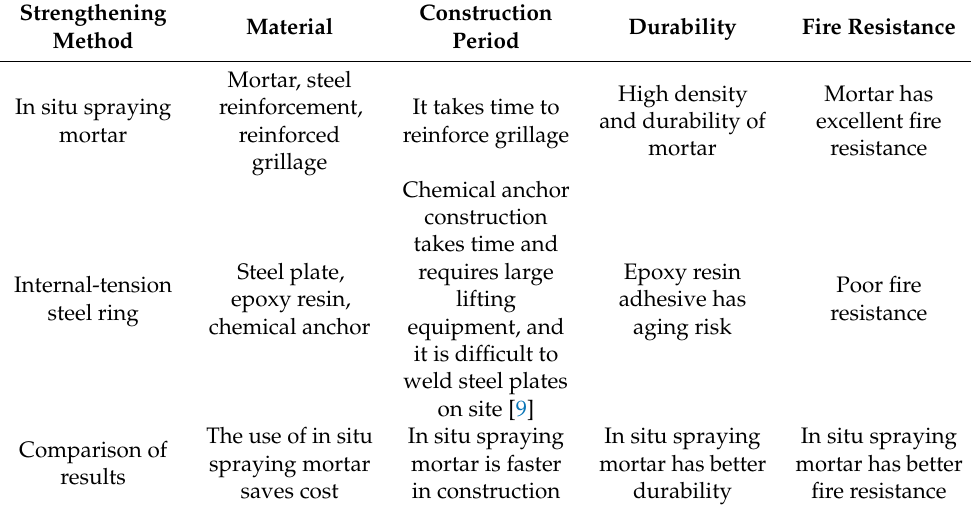
Table 5. Comparison of engineering economics of the two strengthening